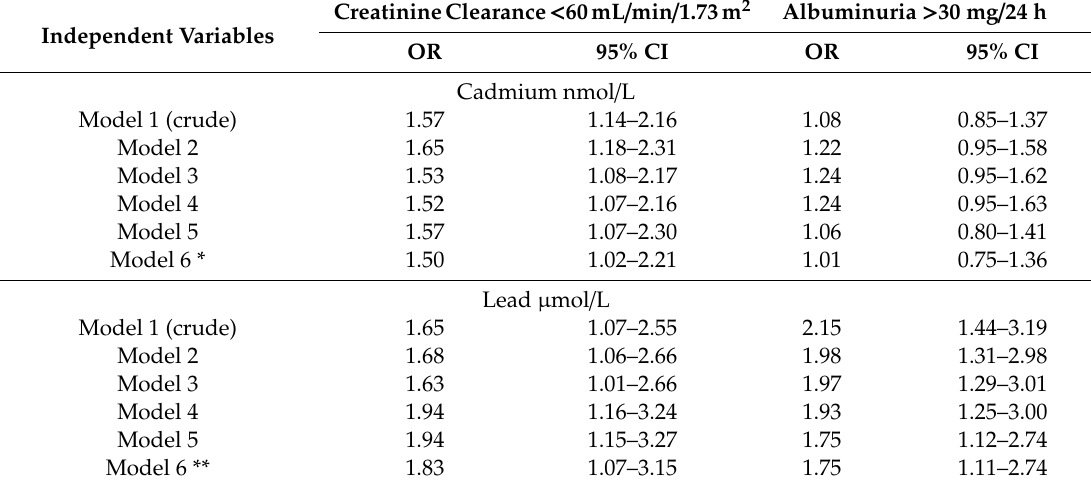
Table 4. Multivariate logistic regression on the association between Cd and Pb and albuminuria and reduced creatinine